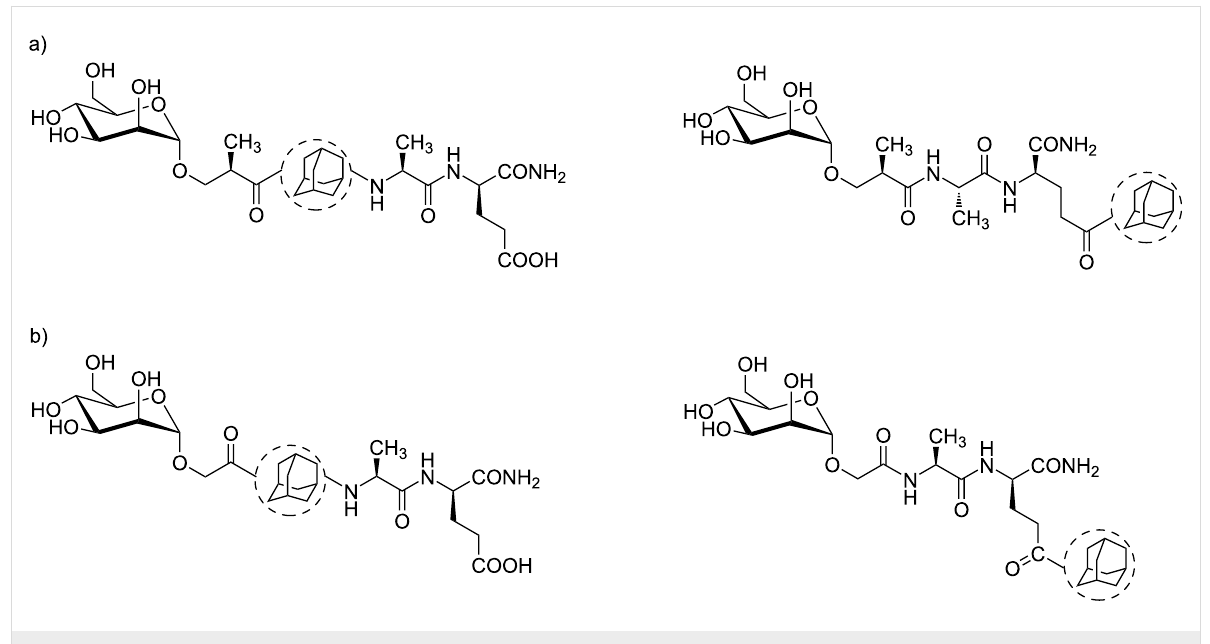
Figure 3: General structure of: a) glycolyl and b) ( R )-hydroxyisobutyryl